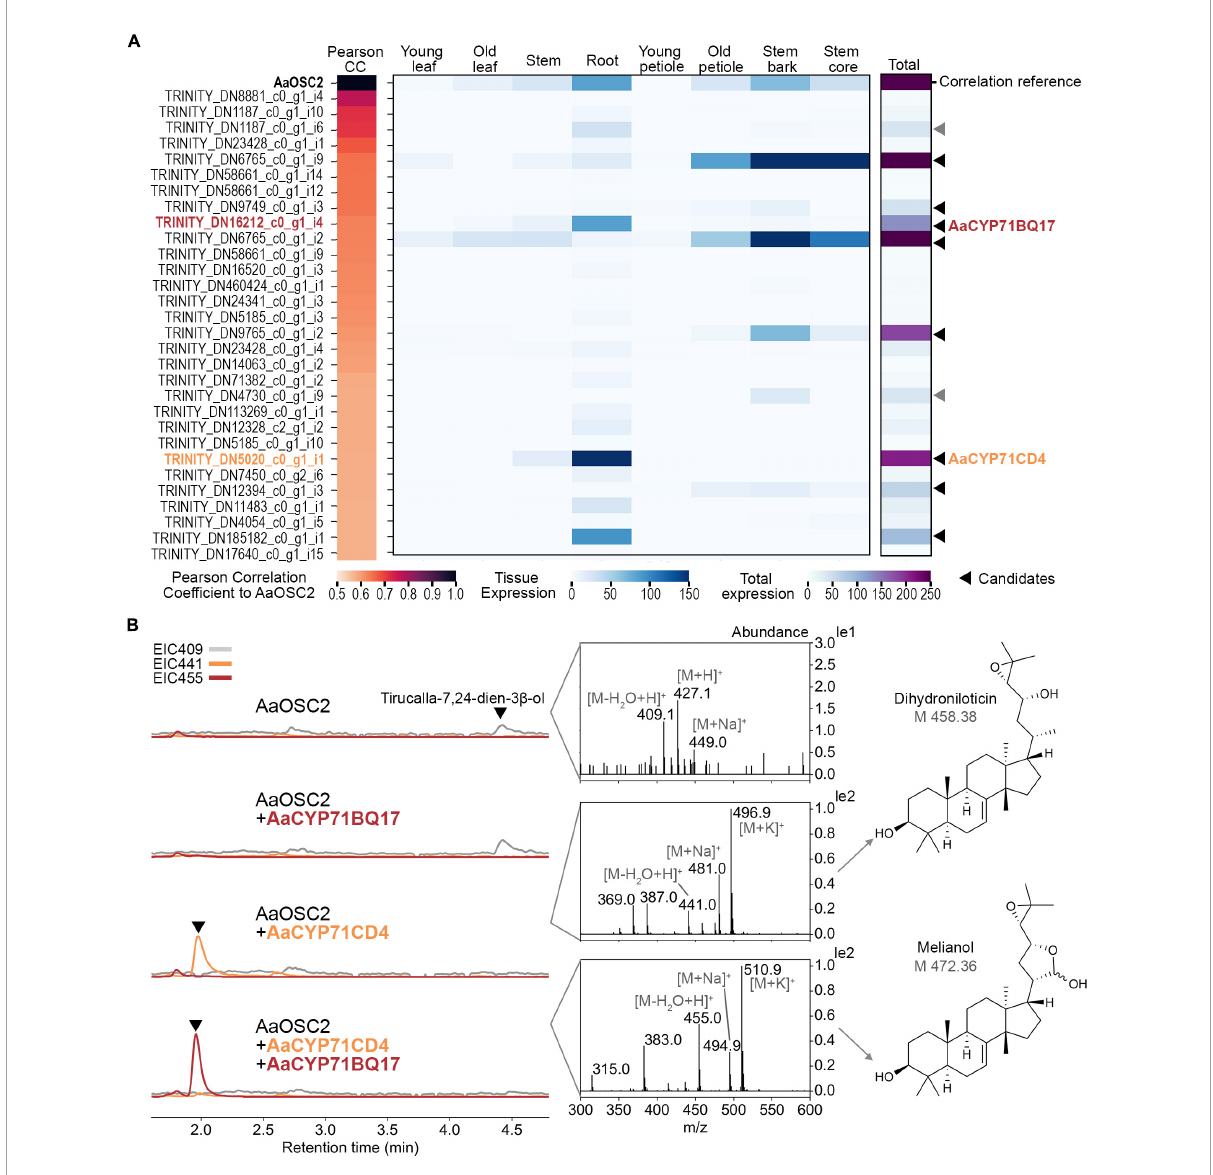
FIGURE4 Discovery of the two cytochrome P450 enzymes AaCYP71CD4 and AaCYP71BQ17 which convert tirucalla-7,24-dien-3 β -ol into the protolimonoid melianol during quassinoid biosynthesis. (A) Top 30 cytochrome P450-encoding contigs co-expressed with the tirucalla-7,24-dien-3 β -ol synthase gene AaTS ranked by Pearson’s correlation coefficients (CC). Pearson’s CC values and expression data [trimmed mean of M -values (TMM)] are shown as a heatmap. Young leaf, old leaf, stem and root tissues were from 8-week-old seedlings; young petioles, old petioles, bark and wood were from 3-year-old trees. The 10 candidates with the highest expression (indicated by arrows) were selected for functional validation by co-expression. Of these, two candidates could not be cloned successfully (grey arrows). (B) Extracted ion chromatograms of co-expression experiments in Nicotiana benthamiana analysed by LCMS. All candidates were co-expressed with booster genes. Mass spectra of the indicated peaks (arrows) are shown. The product from co-expression of AaOSC2 , AaCYP71CD4, and AaCYP71BQ17 was confirmed as melianol by